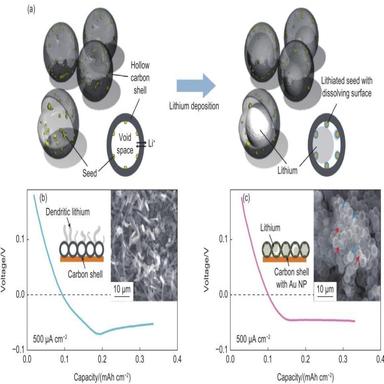
a) Schematic of the nanocapsules design. (b, c) Voltage profile of hollow carbon shells (b) without and (c) with Au NPs during Li deposition process, respectively. Reproduced by permission of Nature Publishing Group